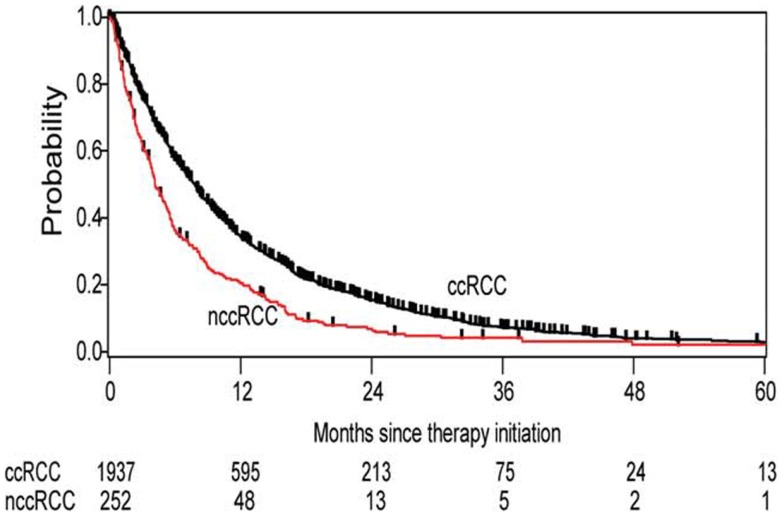
Kaplan–Meier estimates of overall survival in all patients with clear cell histology vs non-clear cell histology.